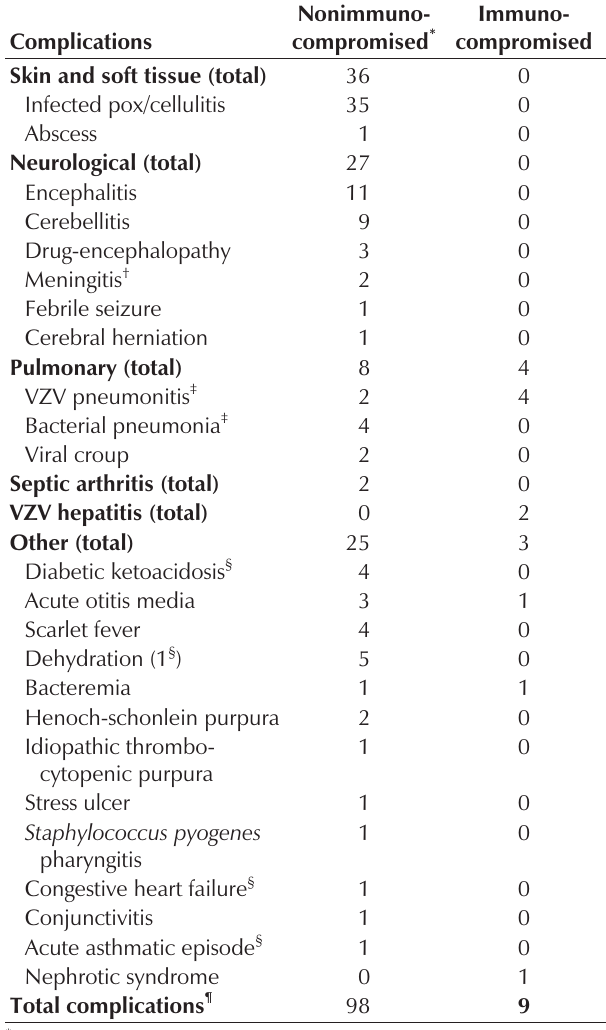
Demographics and presentation in 165 children admitted with varicella zoster virus (VZV) infection Characteristics